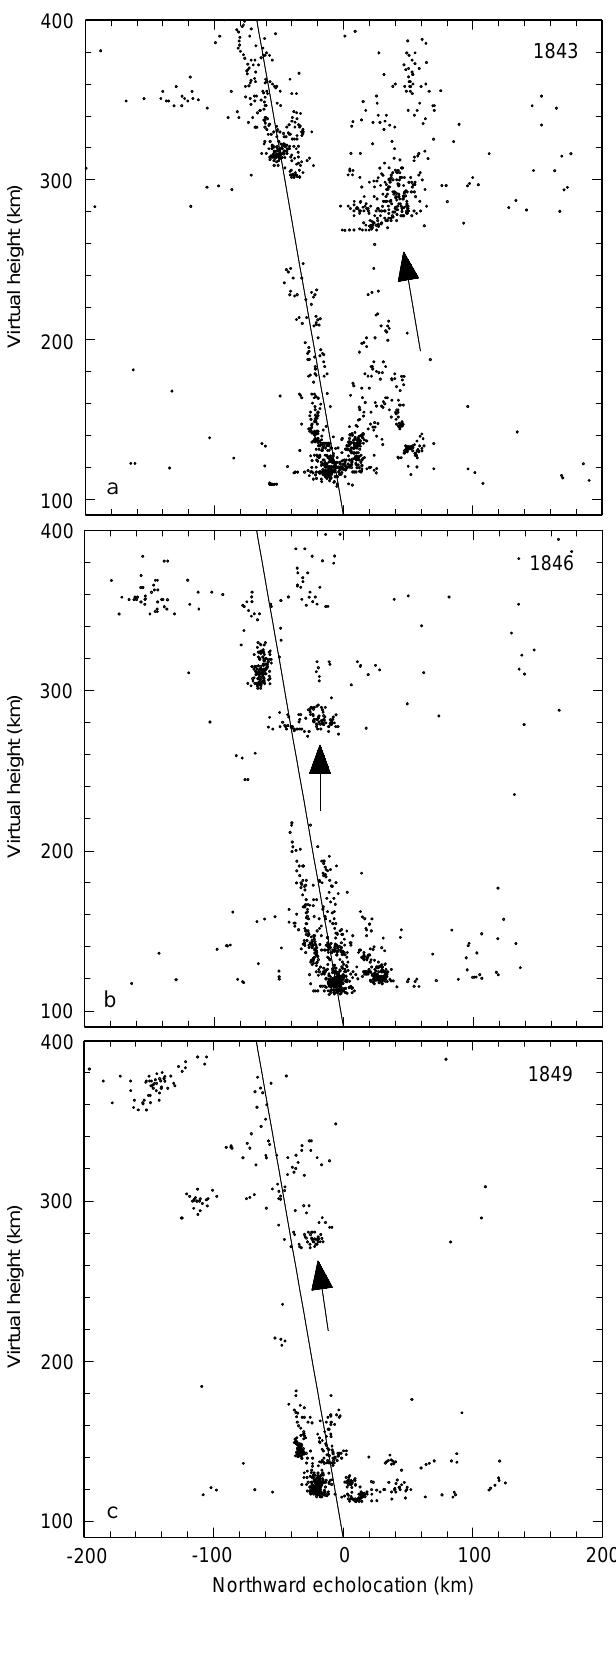
Fig. 5a (cid:177) c. Time series of Dynasonde skymaps showing the north- south drift of an F -region electron density enhancement ( arrowed ) from 1843 to 1849 UT during the experiment SP-UK-DYNA, 23 May 1994. The feature is at a real height of around 240 km. The local magnetic field line is shown on these plots, the dip angle at Troms (cid:249) being 77.5